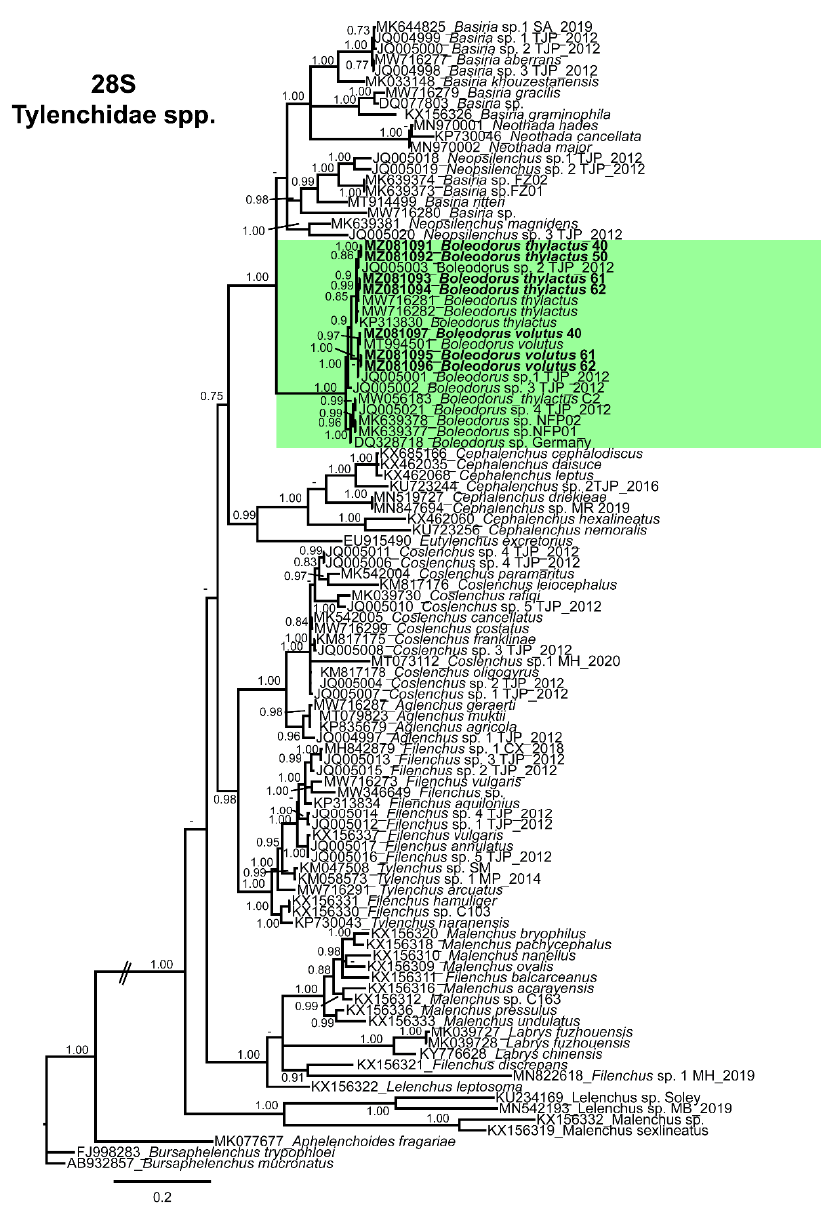
Figure 6. Phylogenetic relationships of the genus Boleodorus spp. within Tylenchidae. Bayesian 50% majority rule consensus tree as inferred from D2–D3 expansion domains of the 28S rRNA sequence alignment under the transversion model with invariable sites and a gamma-shaped distribution (TVM + I + G). Posterior probabilities of more than 0.70 are given for appropriate clades. Sequences newly obtained in this study are shown in bold. The scale bar indicates expected changes per site. Boleodorus spp. clade in green color.